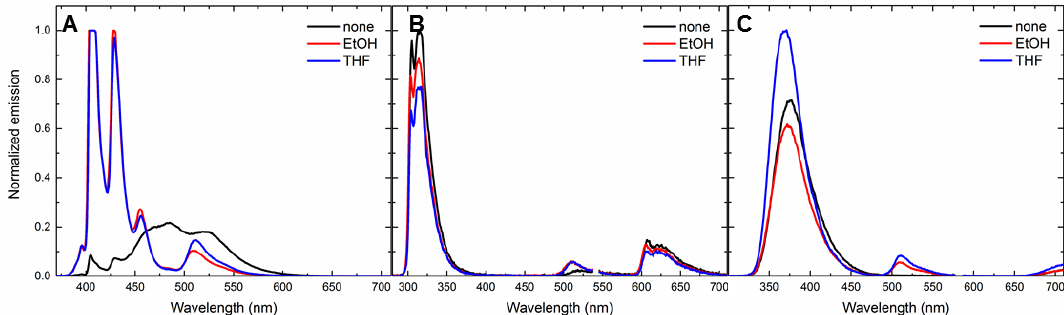
Figure 8. A comparison of the fluorescence emission in γ -cyclodextrin in the absence (black line) and presence of ethanol (red line) and THF (blue line) with ( A ) analyte 1 ; ( B ) analyte 3 ; and ( C ) analyte 6 with compound 7 .